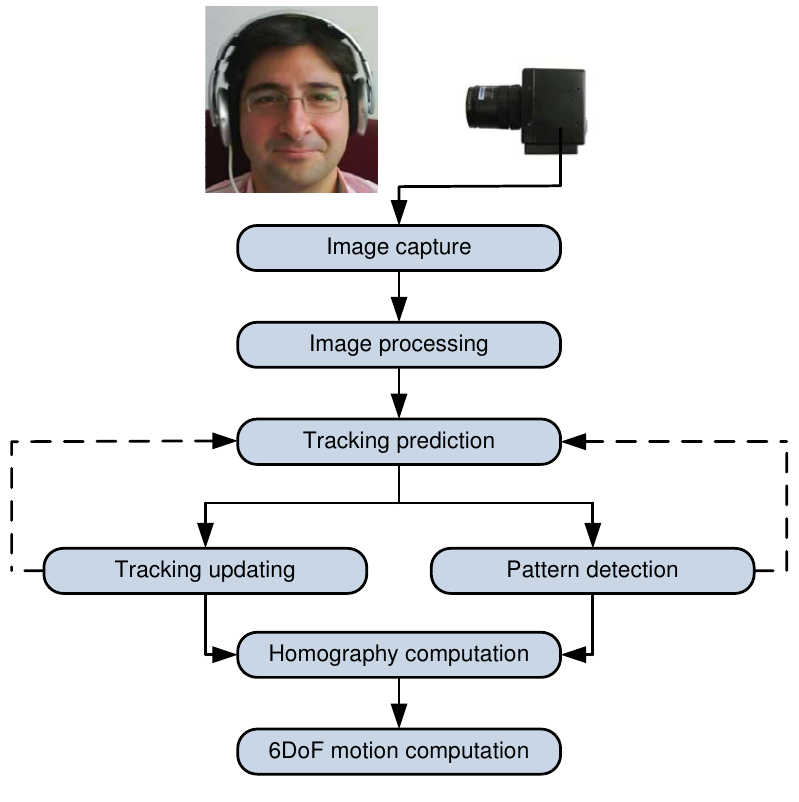
Figure 3. Different stages involved in the proposed head tracking